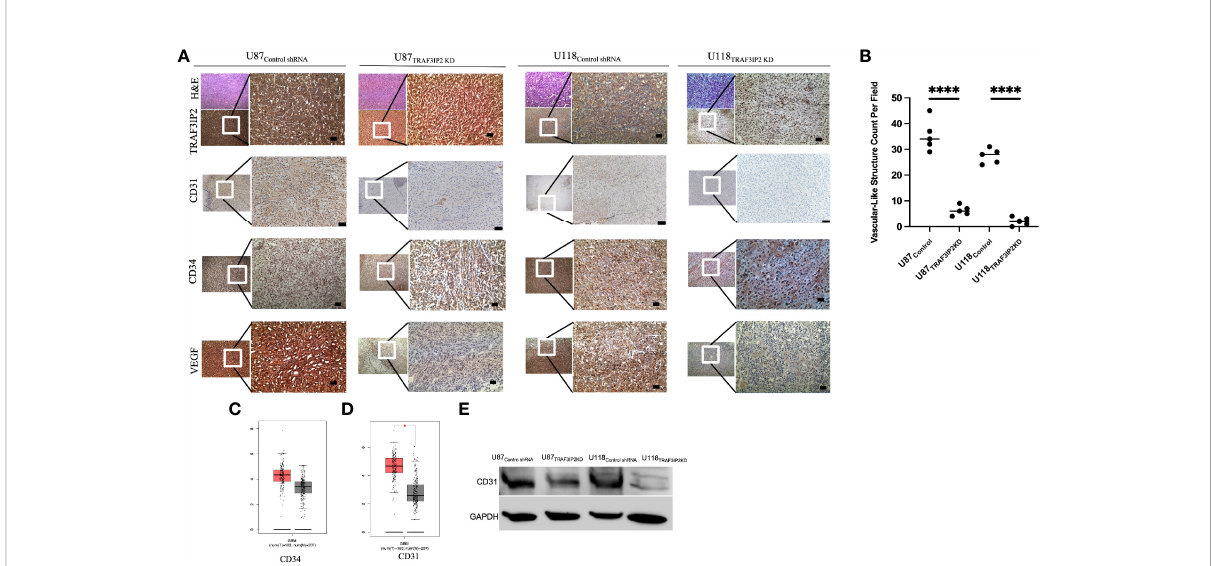
FIGURE 2 Immunohistochemical analysis demonstrating that knockdown of TRAF3IP2 in GBM reduces angiogenic markers. The U87 and U118 cells were transduced with anti-TRAF3IP2-shRNA (U87 TRAF3IP2KD and U118 TRAF3IP2KD , respectively) to silence TRAF3IP2 or Scrambled-shRNA (U87